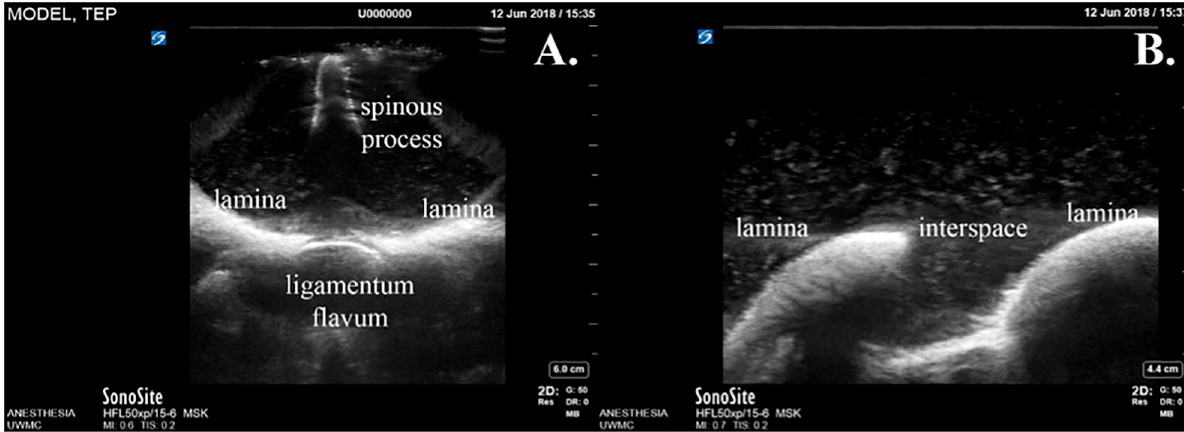
Fig 6. Ultrasound images obtained from the model. Transverse view (A) and paramedian view (B).